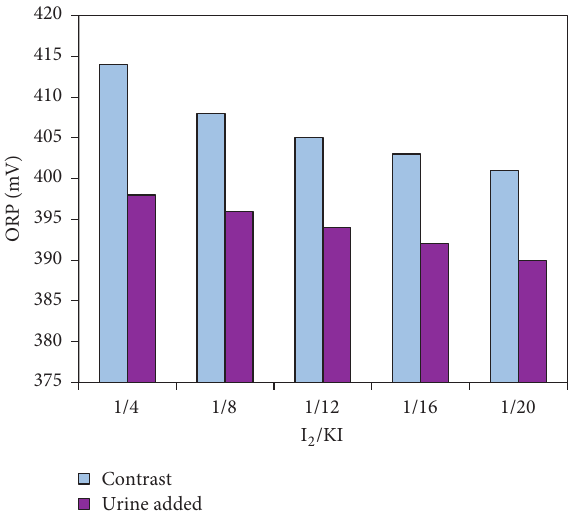
Figure 3: ORP changes reacted with urine using electrode solutions with different concentration ratios.